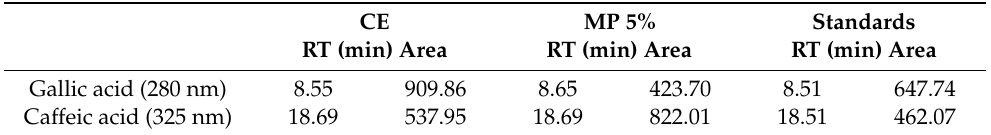
Table 3. Polyphenols identified in the crude extract and microparticle with the identification of the retention time of each peak and their respective